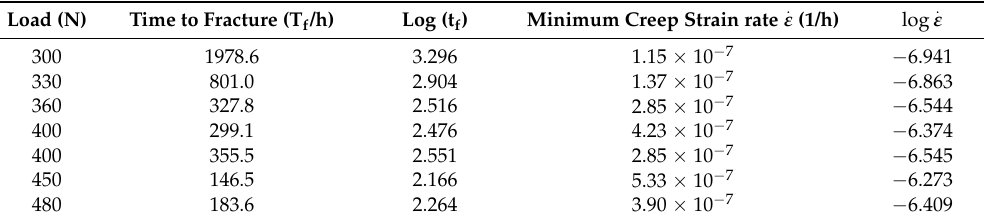
Table 4. The minimum strain rate and time to fracture data of 16Mo3.